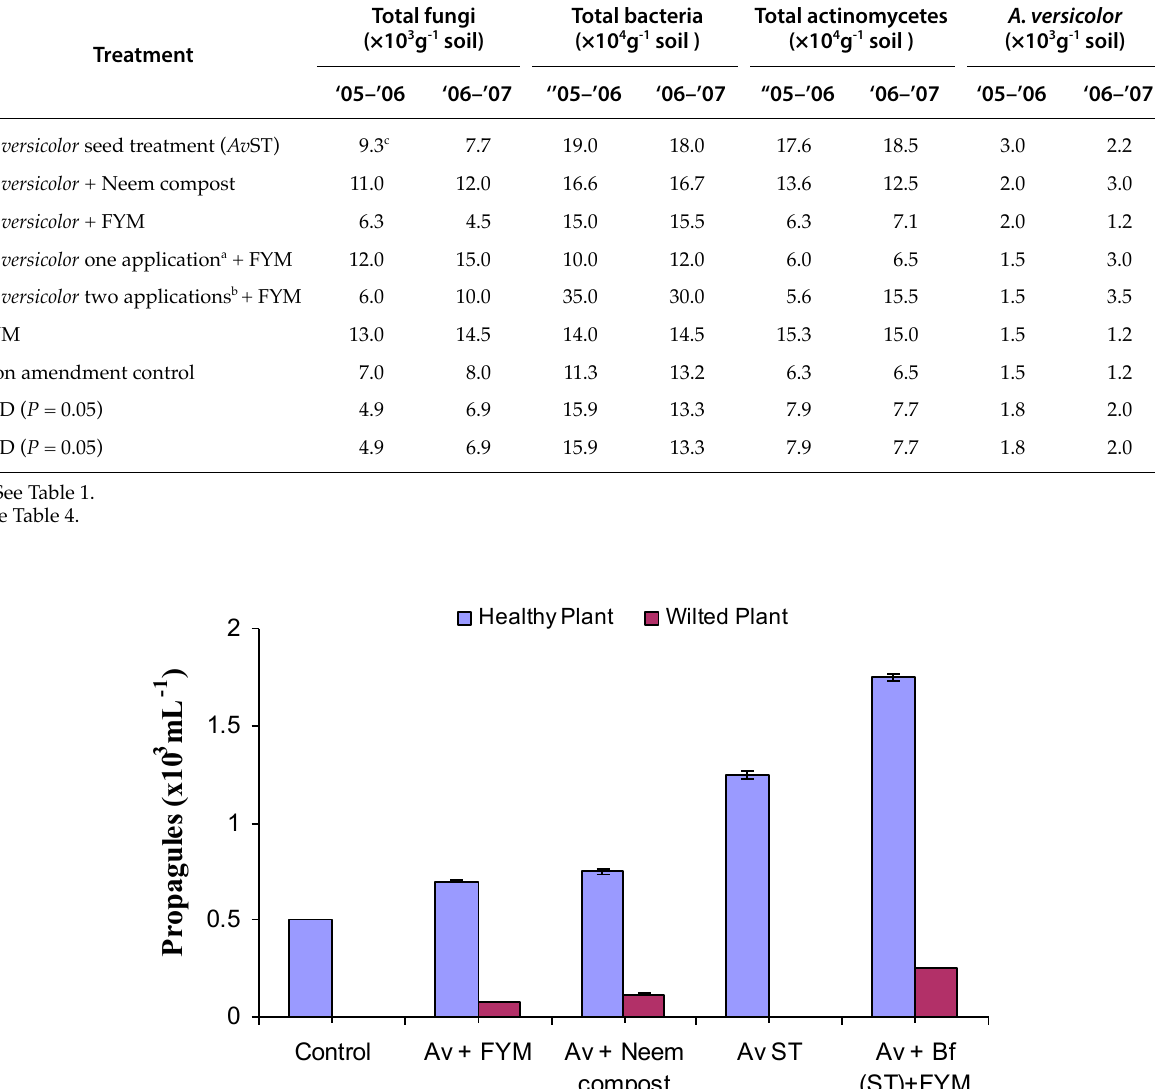
Figure 1. Mean colonization of cumin roots (1 cm) by Aspergillus versicolor (Av), 45 d after treatment in 2006 with